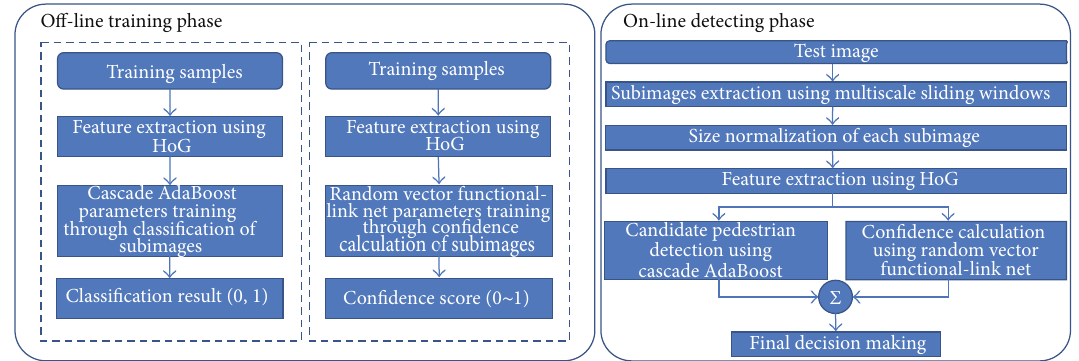
Figure 1: Flow chart of the proposed pedestrian detection system. The proposed pedestrian detection system contains an off-line training phase and an on-line detecting phase. These parameters of CAB detector and RVFL net are trained on the off-line training phase with training samples. All these testing subimages are extracted and verified to be targets or not during the on-line